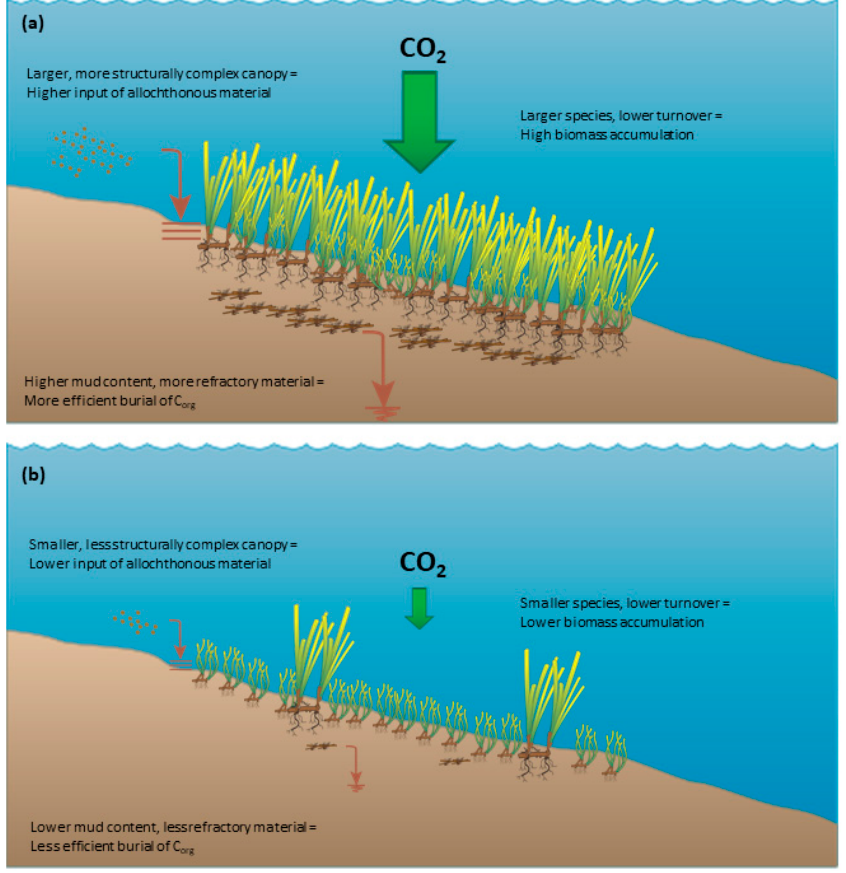
Figure 1. Three key processes in accumulation of seagrass carbon stock: biomass accumulation, input of allochthonous material, and efficient burial of C org , and examples of the biophysical characteristics which drive higher ( a ) and lower ( b ) carbon stocks.